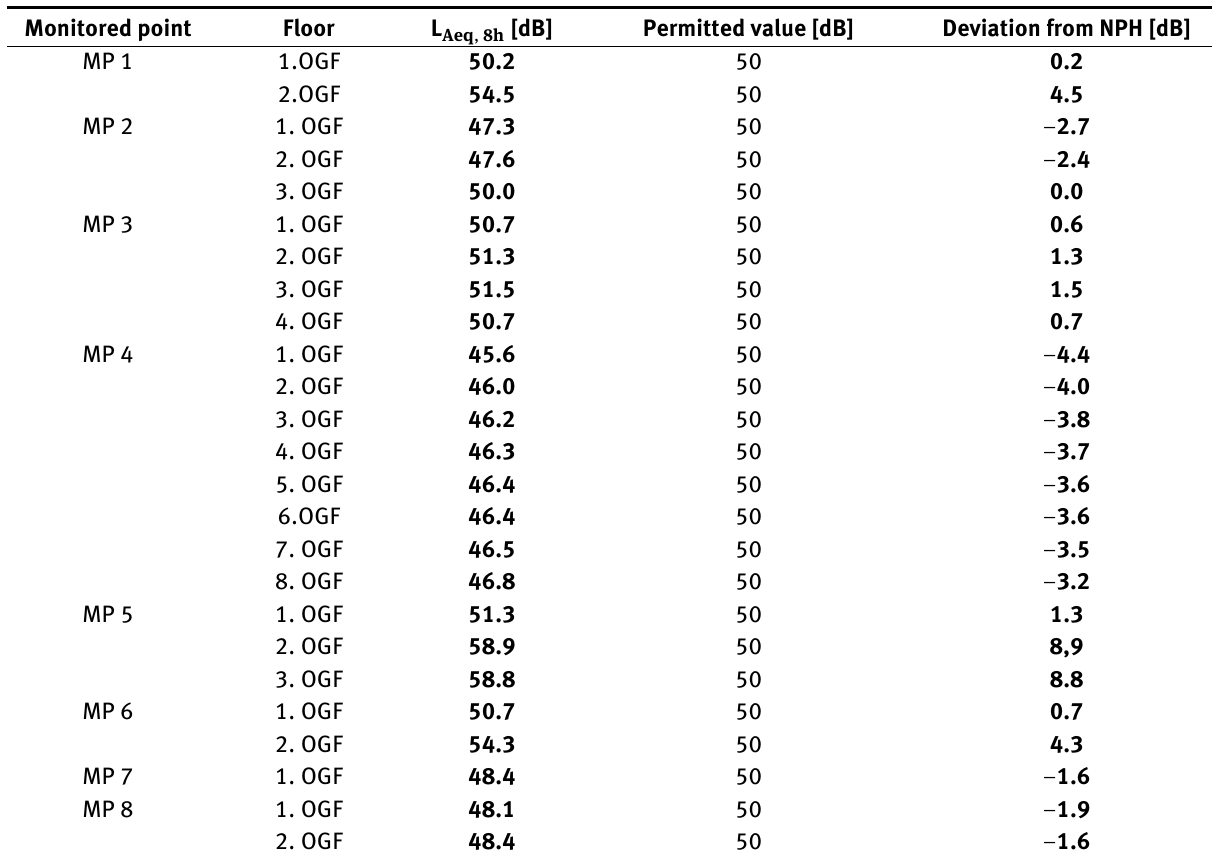
Table 6: Calculated levels for a variant with the construction of a bypass - reference time interval - night Monitored